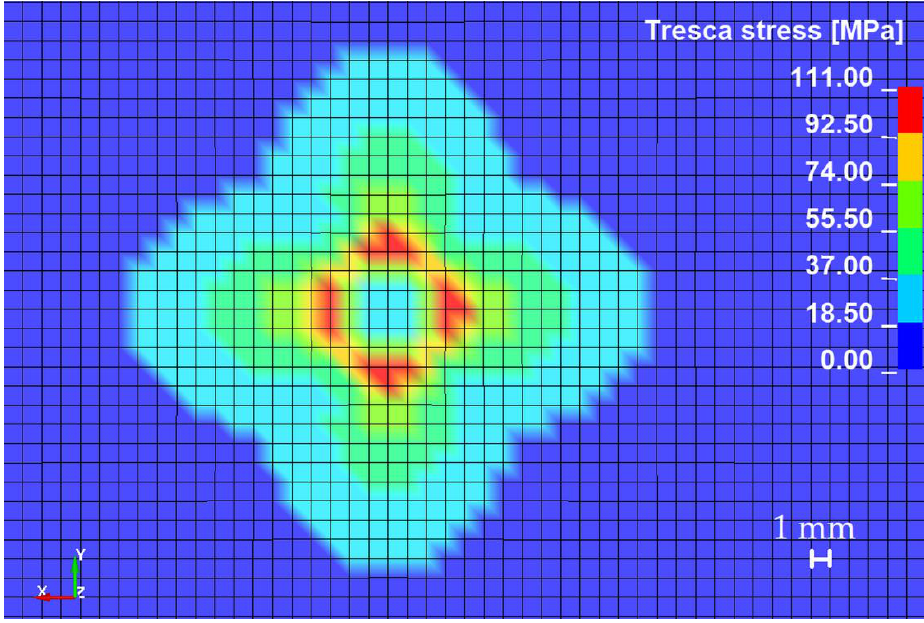
Figure 8. Colored map of Tresca equivalent stress on the first layer of reinforcement in case of blunt striker